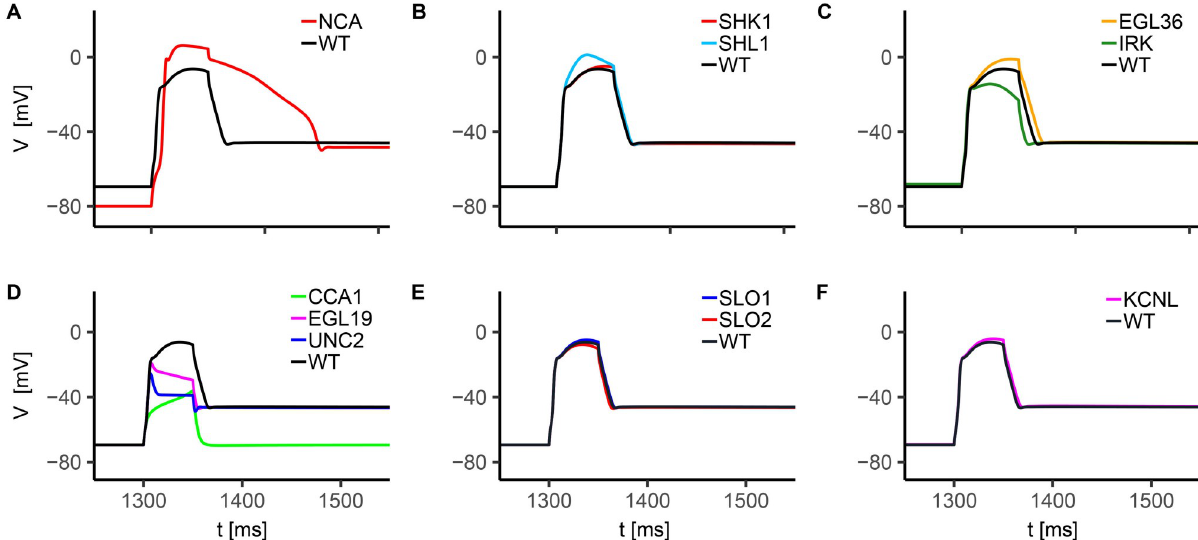
Fig 9. In silico RMD knockouts voltage response to current injection. The stimulation protocol consists in a single 10 pA current step with a duration of 50 ms. The holding current is I h = 0 pA. Each knockout is obtained by suppressing the contribution of the desired current, leaving unchanged the other conductances. In panels A-F we report the response of NCA (A), voltage-gated potassium channels (B and C), voltage-gated calcium channels (D), and calcium-regulated potassium channels (E and F) knockouts.